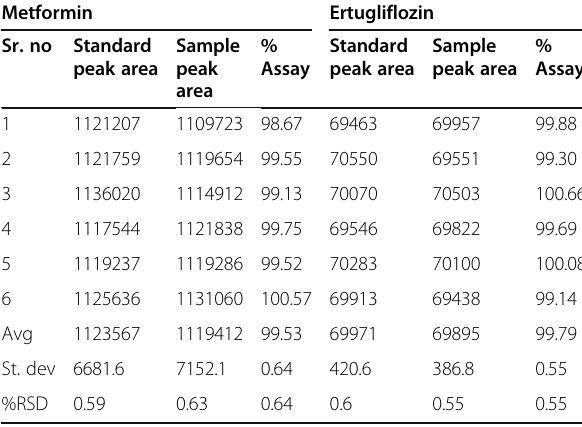
Table 6 Results of Assay of Metformin and Ertugliflozin Metformin Ertugliflozin